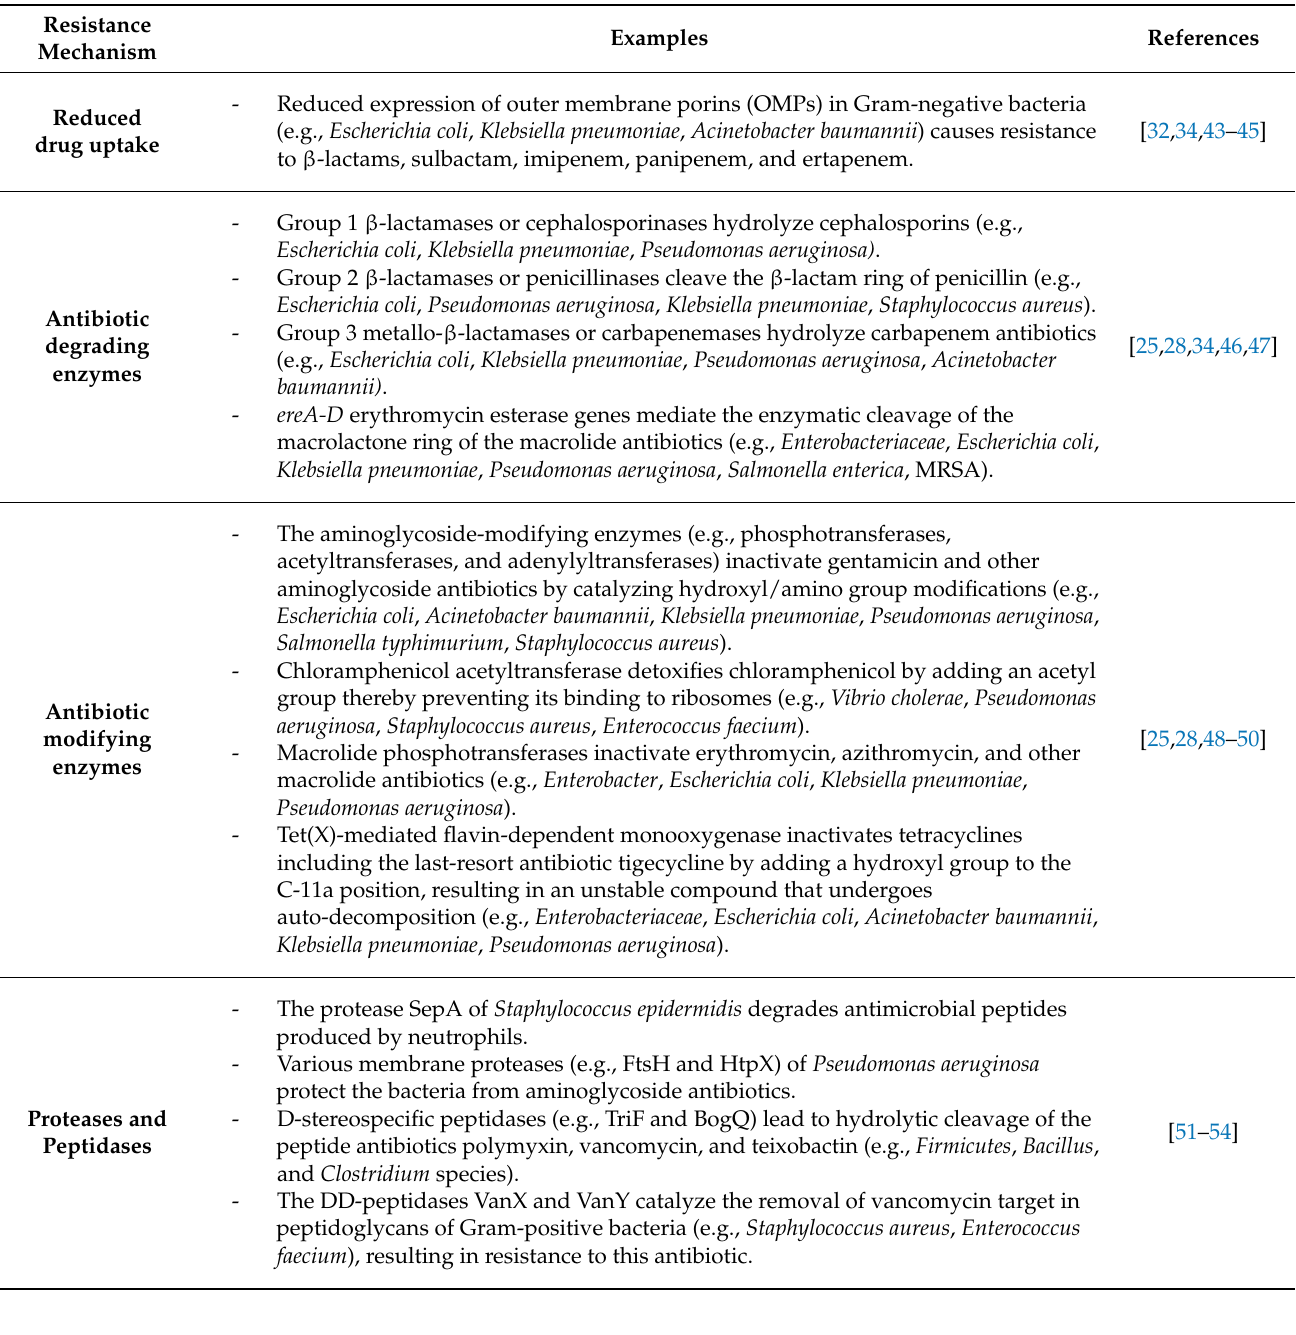
Table 1. Various antibiotic resistance mechanisms in Gram-positive and Gram-negative